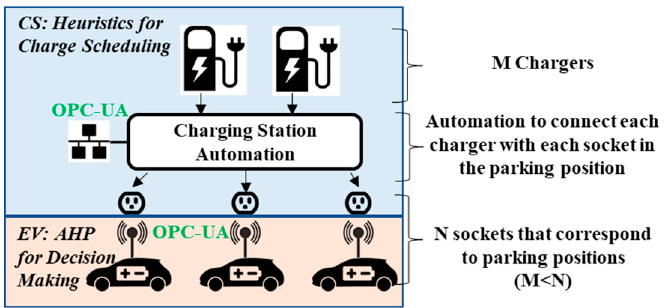
Figure 1. Overall representation of the smart charging framework.